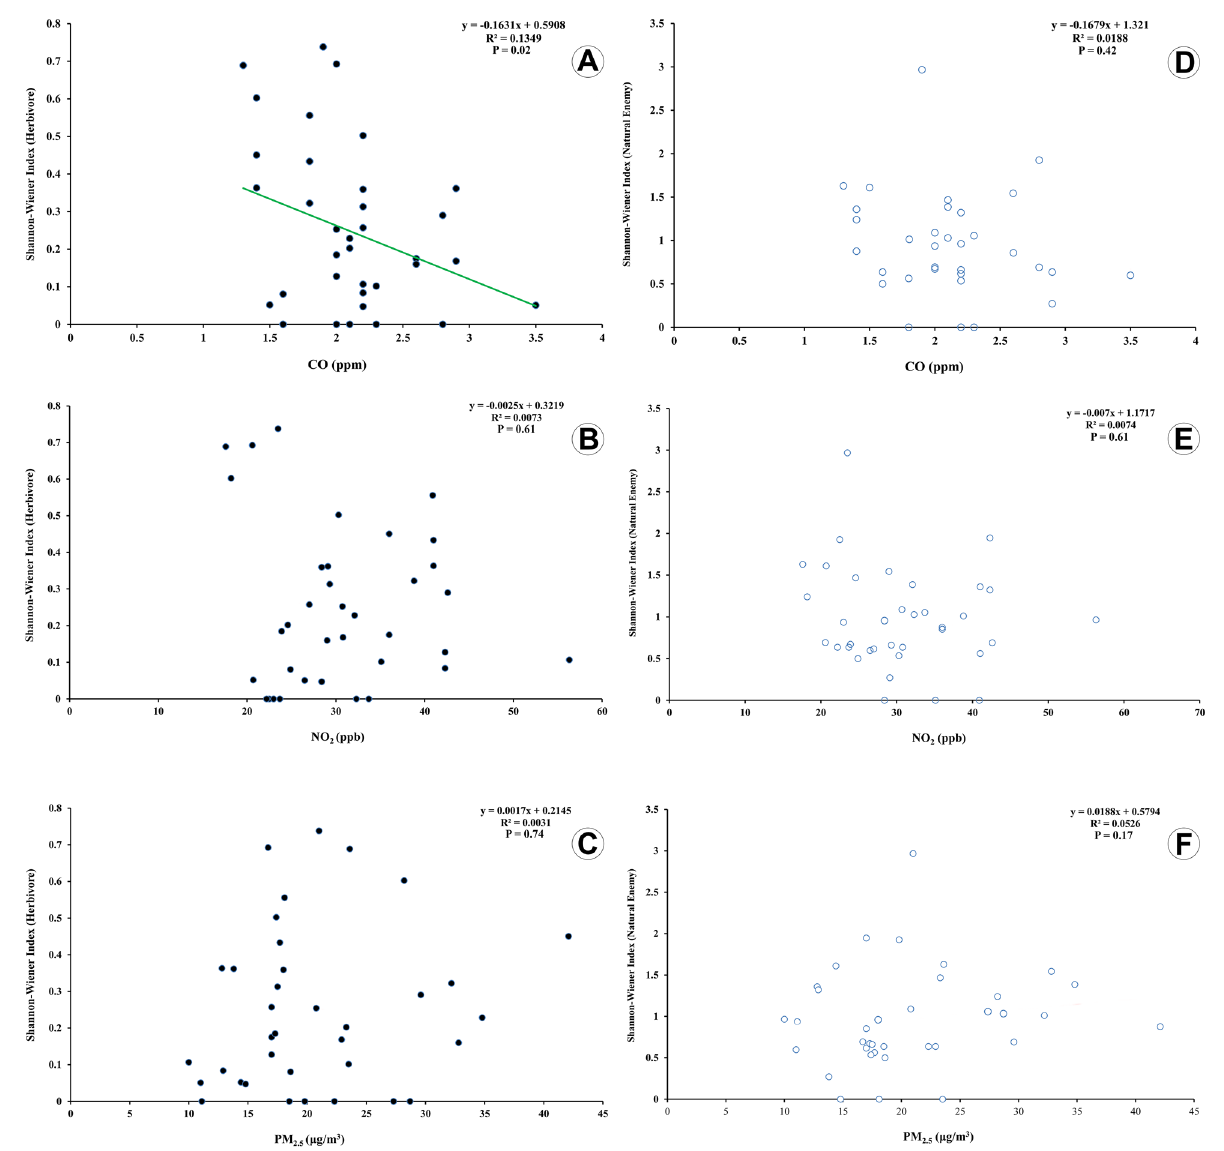
Figure 6. The Shannon–Wiener index regression of insect fauna associated with Chinese thuja trees , Platycladus orientalis (L.) with three air pollutant concentrations in urban green spaces of Mashhad city from Iran. Herbivores ( A – C ). Natural enemies ( D–F ). CO ( A, D ). NO 2 ( B, E ). PM 2.5 ( C, F